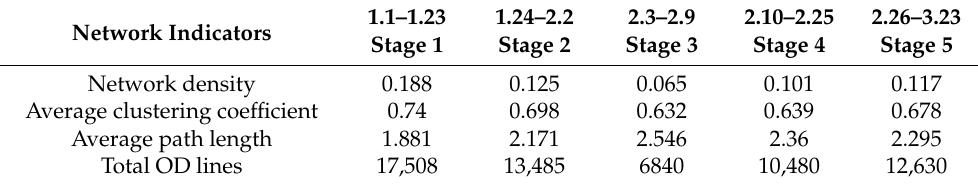
Table 3. Network indicator of PFN in different